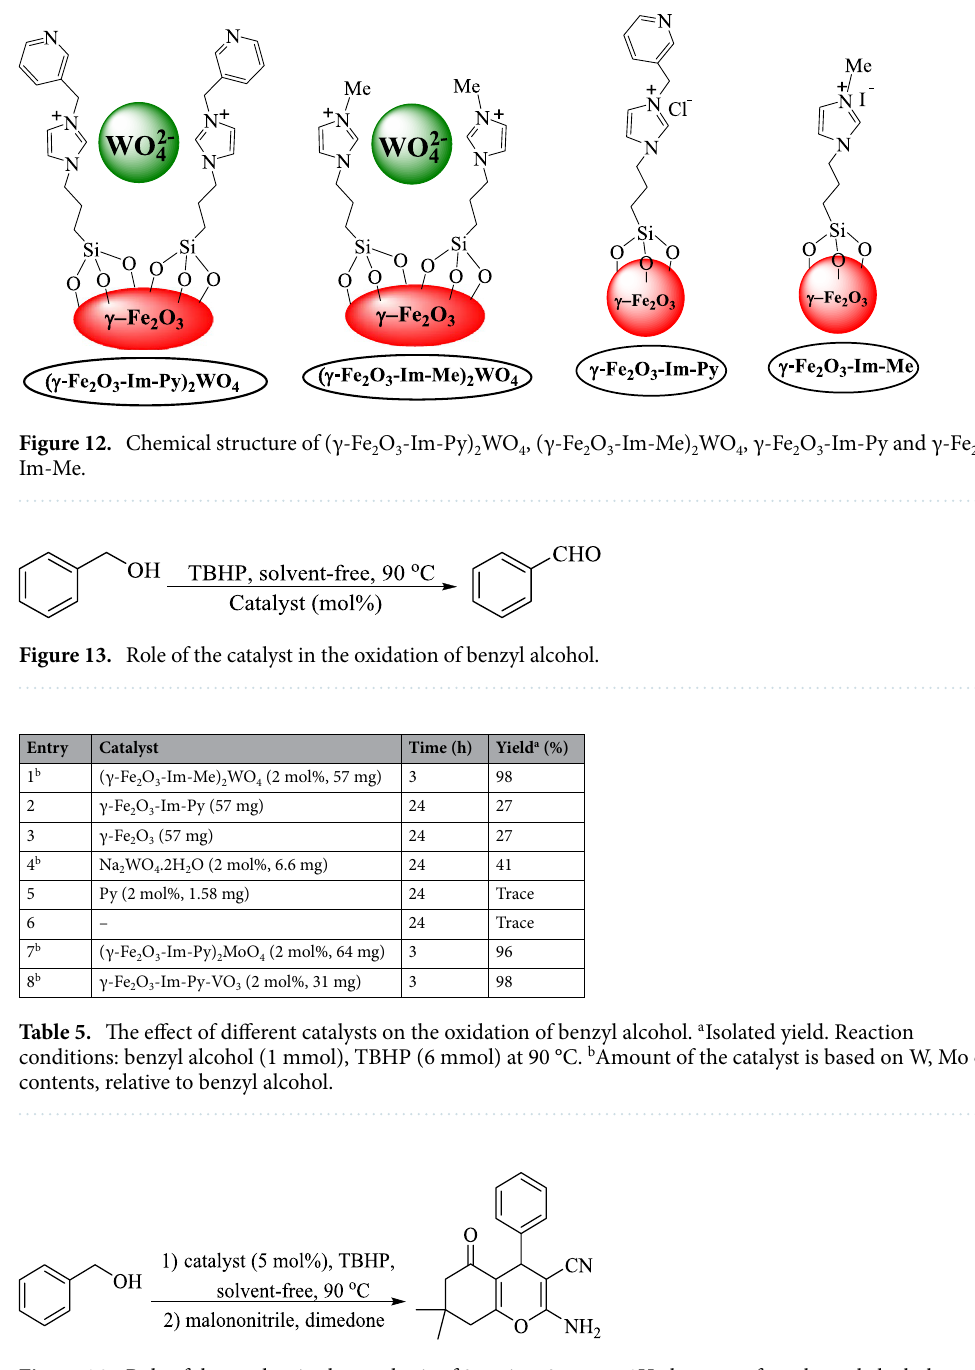
Figure 14. Role of the catalyst in the synthesis of 2-amino-3-cyano-4 H -chromene from benzyl alcohol.